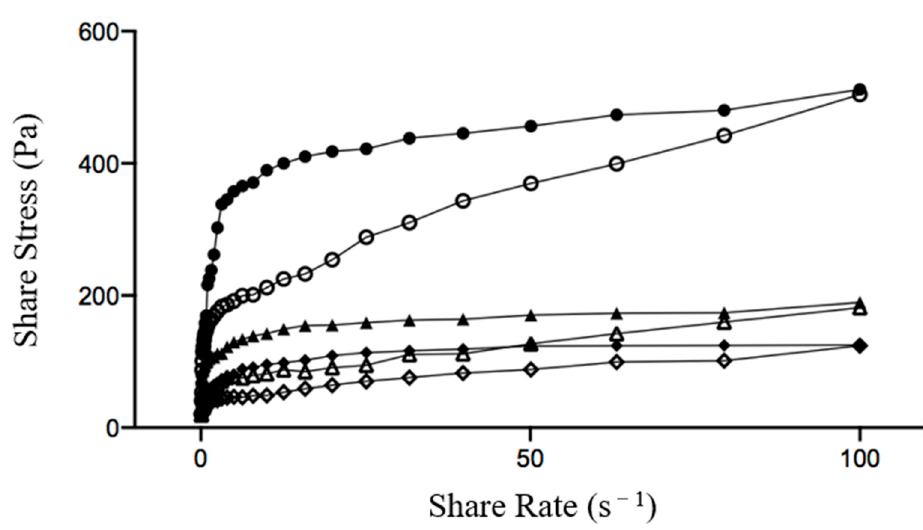
Figure 4. Flow curves and model fitting results of yogurt without SPI (control, ♦ , ◊ ), or with SPI ( ▲ , △ ) and HHP-SPI ( ● , ○ ). Shear rate was first increased ( ♦ , ▲ , ● ) and then decreased ( ◊ , △ , ○ ). Table 3. The model fitting results of yogurt without SPI (control) or with SPI and HHP-SPI.